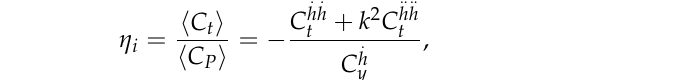
Figure 11. Ideal efficiency of a rectangular wing heaving in extreme ground effect ( h → 0 ) and out of ground effect [33] for Strouhal numbers tending to zero.